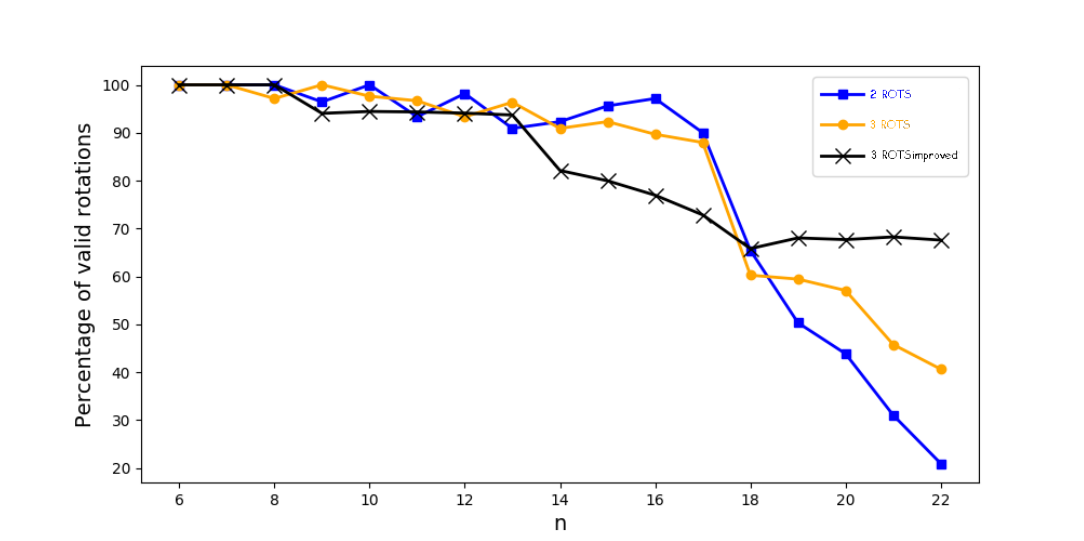
Figure 7. Evolutions of the percetages of valid rotations for the different models according to the degree of the primitive